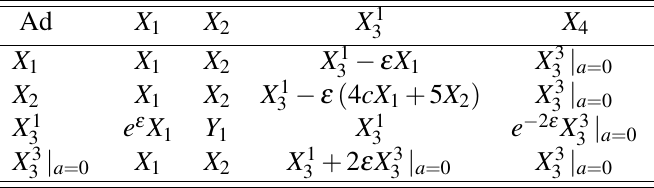
1 | a = 0 } , X 3 1 , X 2 , X 3 3